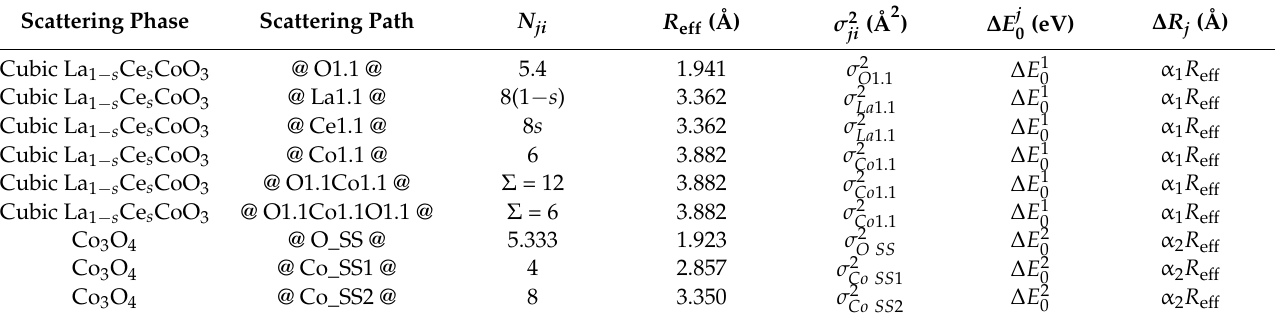
Table 3. EXAFS model for Co K -edge spectra of the x = 0.2 and x = 0.4 samples based on the two-phase mixture. Co 3 O 4 has two inequivalent absorbing sites. The symbol @ denotes the absorbing